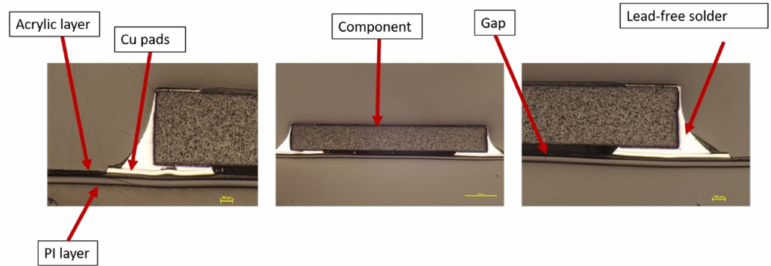
Figure 20. Cross-section images for flat surface.